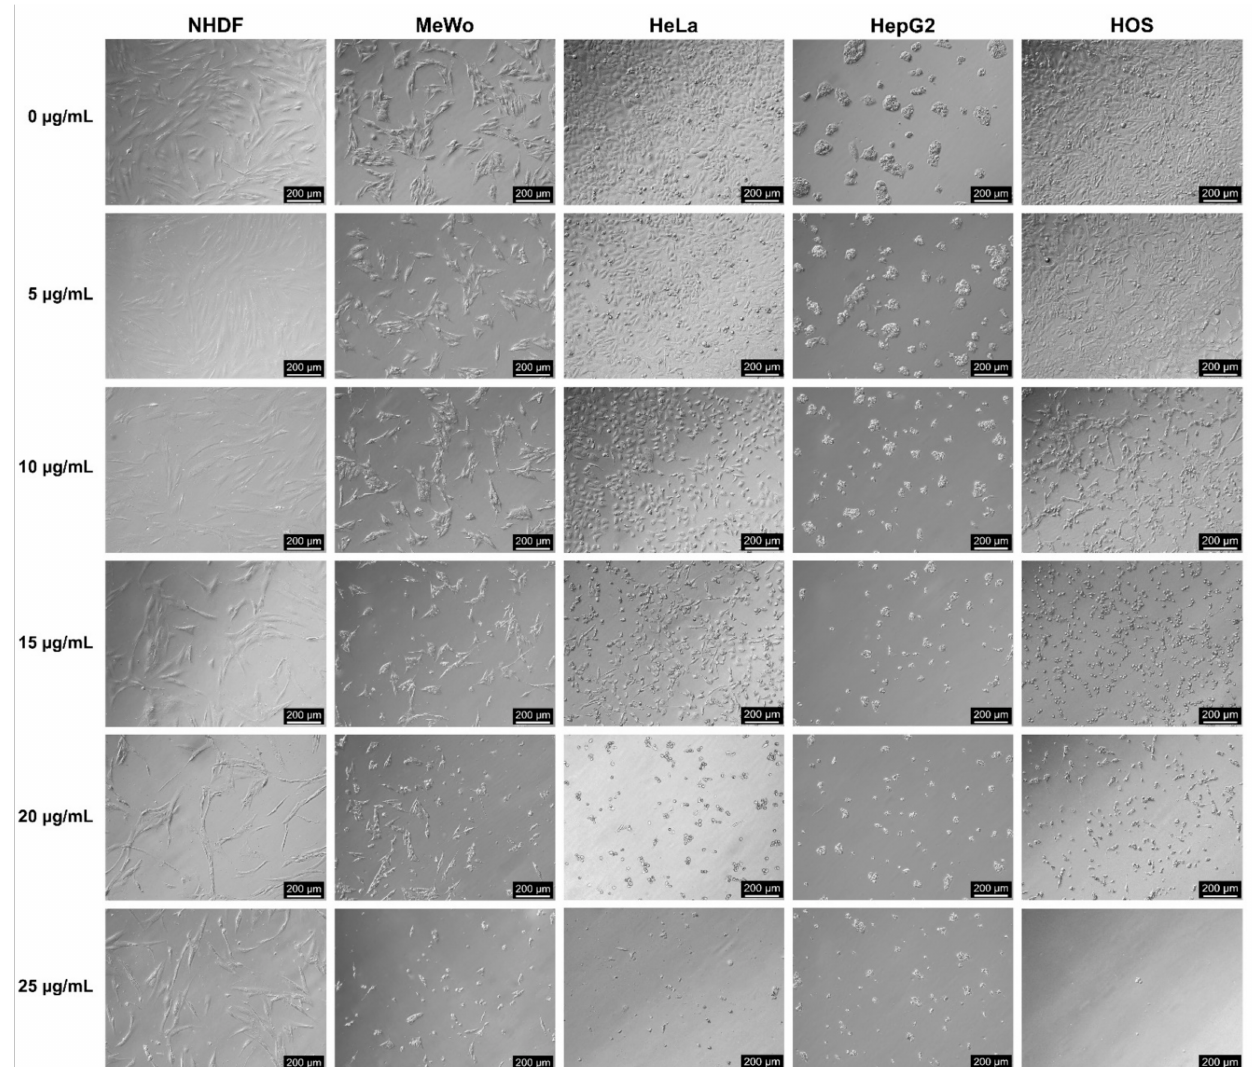
Figure 7. Morphological analysis of normal dermal fibroblasts (NHDF), malignant melanoma (MeWo), adenocarcinoma (HeLa), hepatocellular carcinoma (HepG2) and osteosarcoma (HOS) cells treated with CBD-enriched hemp oil at 5, 10, 15, 20 and 25 µ g CBD/mL for 48 h. Control cells were incubated with complete cell culture medium (represented as 0 µ g